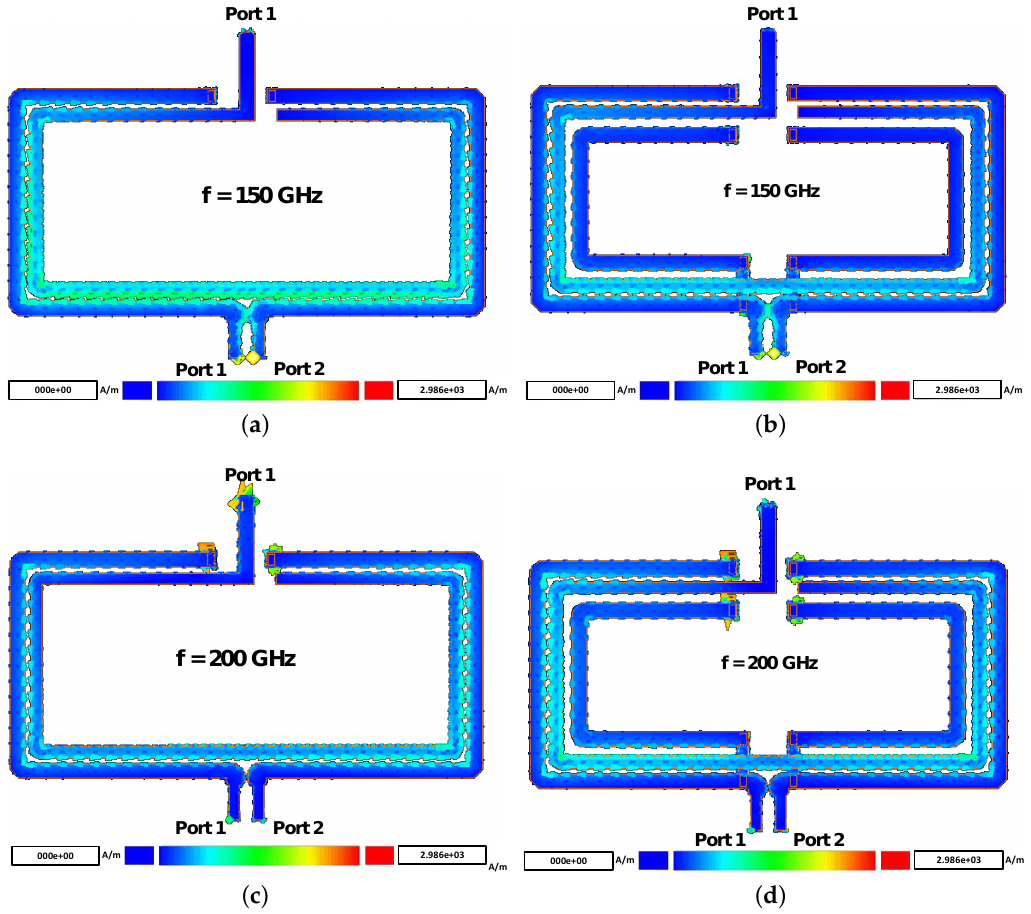
Figure 7. Simulated surface current distribution at 150 GHz of Balun 1 ( a ) and Balun 2 ( b ) and at 200 GHz of Balun 1 ( c ) and Balun 2 ( d